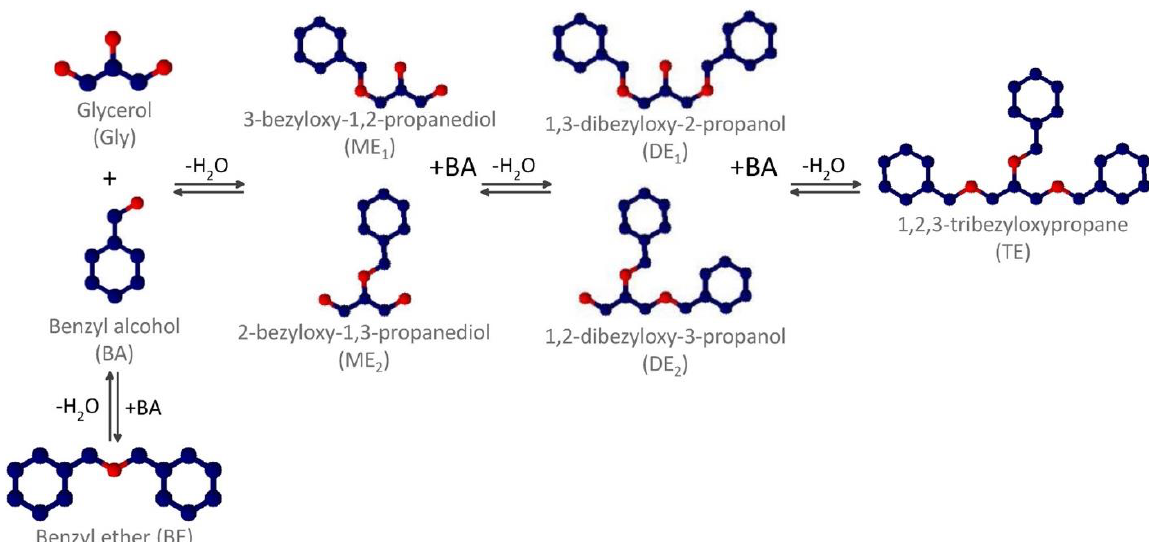
Figure 6. Etherification reaction of glycerol (Gly) with benzyl alcohol (BA) (reproduced with permission of ref. [63]).